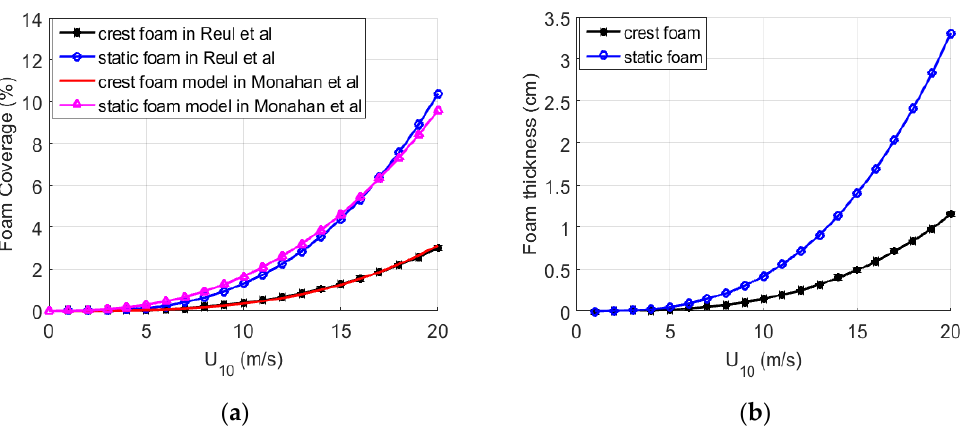
Figure 1. Foam coverage and foam thickness at different wind speeds. ( a ) Foam coverage models for crest foam and static foam. ( b ) Foam thickness distributions for crest foam and static foam.